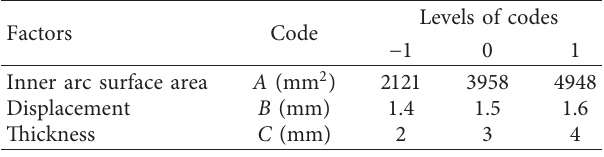
Figure 4: Squeeze deformation. (a) Before extrusion. (b) Extrusion displacement of 2mm. (c) Complete extrusion. Table 2: Factors and levels of the Box–Behnken test.